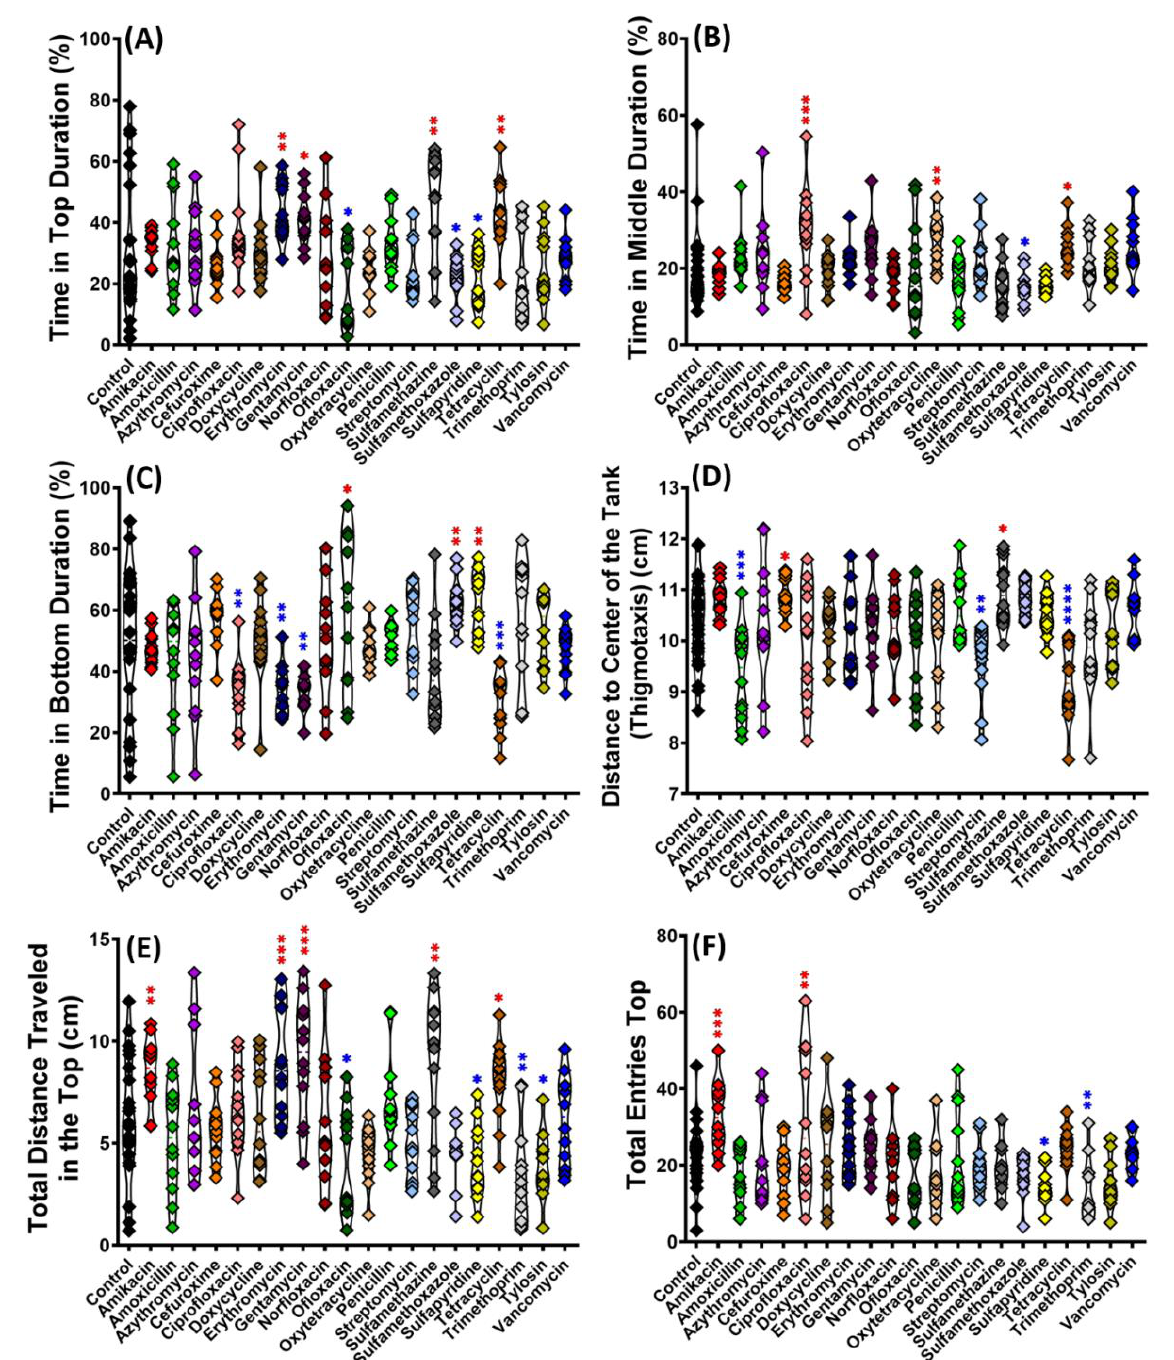
Figure 2. Comparison of exploratory behavior of golden zebrafish after 10 days exposure with different antibiotics in 3D locomotion test. ( A ) Time in top area, ( B ) time in middle area, ( C ) time in bottom area, ( D ) distance to the center of the tank, ( E ) total distance traveled in the top area, and ( F ) total entries in the top area. The data were analyzed by ordinary one-way ANOVA followed by multiple comparison Fisher’s LSD test ( n control: 24, n for each antibiotic group: 12). The significances were indicated by * p < 0.05; ** p < 0.01; *** p < 0.001; **** p < 0.0001 (red asterisk indicates a higher mean value, while blue asterisk indicates a lower mean value than the control).